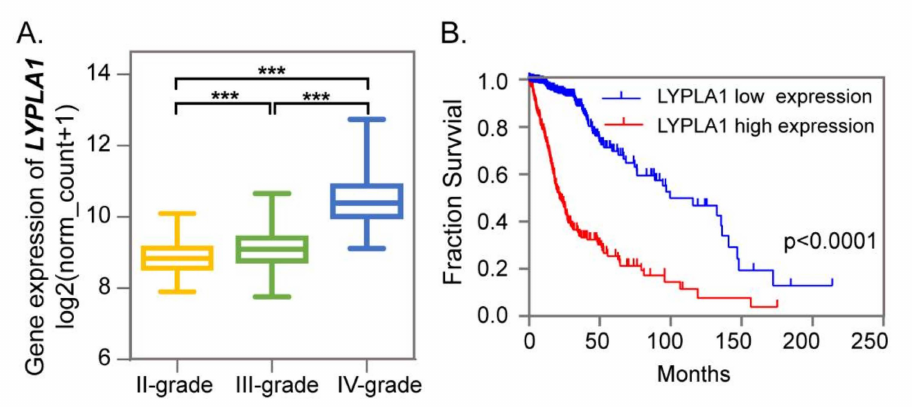
Figure 4. Lysophospholipase 1 (LYPLA1) gene showing higher expression in high-grade gliomas. ( A ) The gene expression of LYPLA1 in di ff erent grades of glioma tissues according to The Cancer Genome Atlas (TCGA) database. ( B ) Kaplan–Meier analysis of patients having higher or lower LYPLA1 expression levels based on TCGA database. Significance level, *** p <